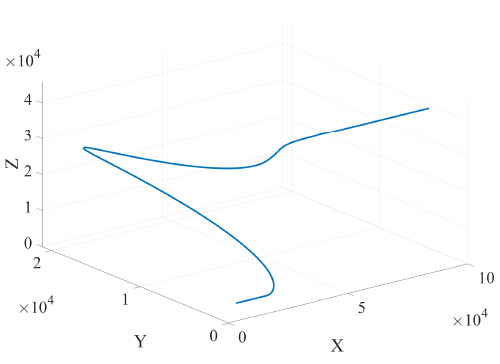
Figure 2. Trajectory command in 3-dimensional space.